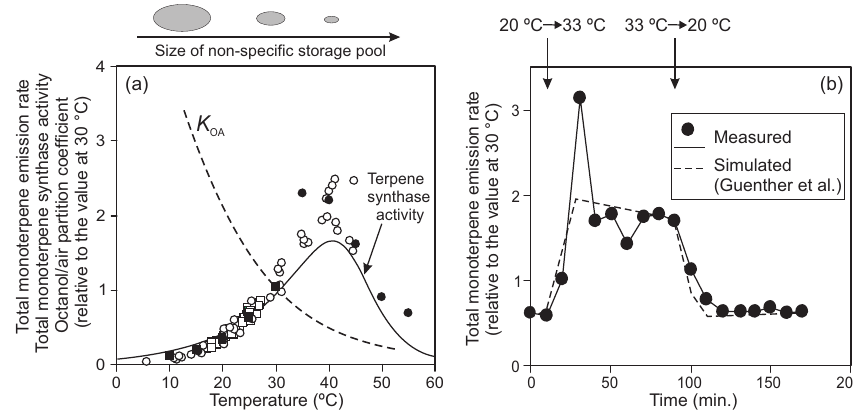
Fig. 6. Temperature effects on monoterpene emission rates from foliage of the broad-leaved evergreen Mediterranean sclerophyll Quercus ilex (symbols), on monoterpene synthase activity (solid line) and α -pinene octanol-to-air partition coefficient ( K OA , dashed line) that charac- terizes the equilibrium size of non-specific monoterpene pool in the leaves (a) , and time-dependent changes in monoterpene emissions from Q. ilex leaves after changes in temperature from 20 ◦ C to 33 ◦ C (b) . In all cases, the data were normalized with respect to the value measured at 30 ◦ C. The emission rate data in (a) are from Bertin and Staudt (1996; open squares), Staudt and Seufert (1995; filled squares), Staudt and Bertin (1998; open circles) and Loreto et al. (1998; filled circles) (Niinemets, 2004 for details on data compilation and fitting). The data in (b) are from Ciccioli et al. (1997a). All measurements were conducted at saturating light and cuvette CO 2 concentrations of approx- imately 350µmolmol − 1 . The measurements of monoterpene synthase activity are from Fischbach et al. (2000) and the K OA estimations from Copolovici et al. (2005; Table 1). Physico-chemical factors likely explain differences between the rates of monoterpene emission and synthesis. As more monoterpenes can be non-specifically stored within the leaves at low temperatures, the emission rates are less than the synthase activity, while at higher temperatures, monoterpenes that have been accumulated at lower temperatures are released. Accordingly, leaves can transiently emit less or more monoterpenes than immediately synthesized. Emission of stored monoterpenes after switching to higher temperature likely explains the monoterpene emission burst in